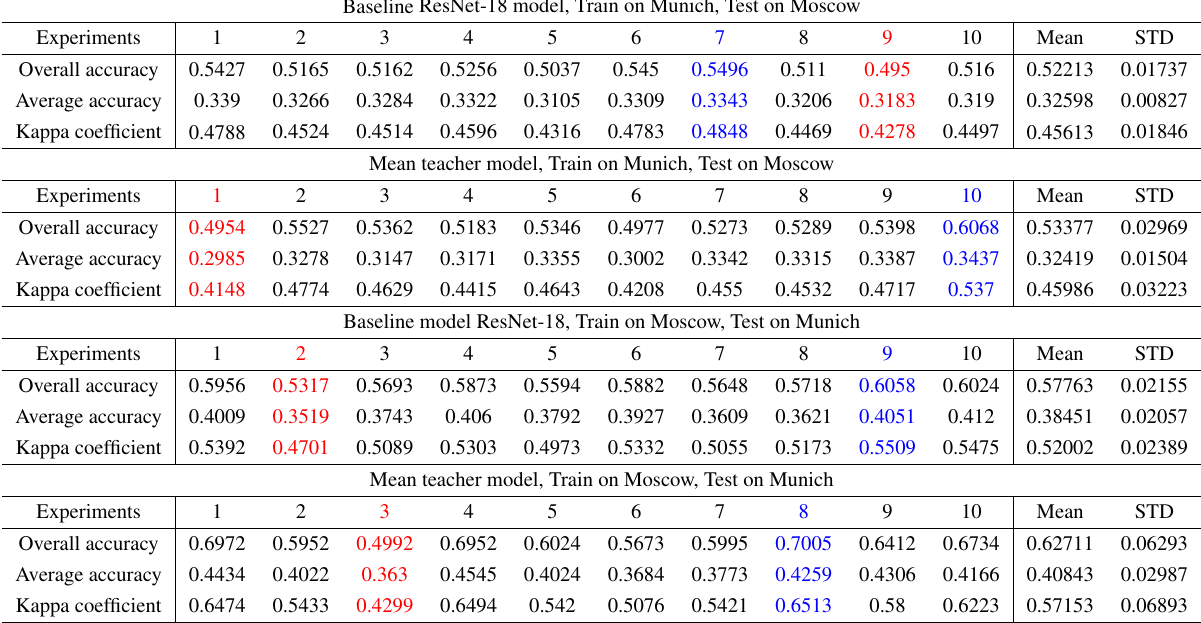
Table 3. Overall accuracy, average accuracy, and kappa coefficient of all repetitions of each experiment setting are shown in this table. The worst and best repetition in terms of overall accuracy are marked in red and blue, respectively.